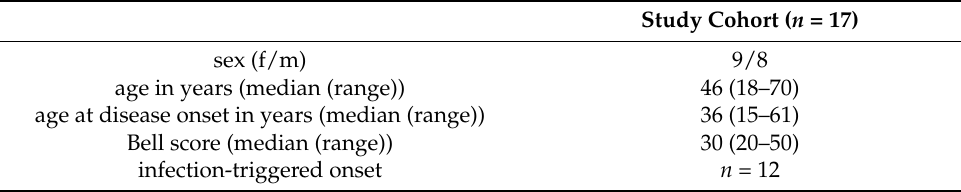
Table 1. Patient